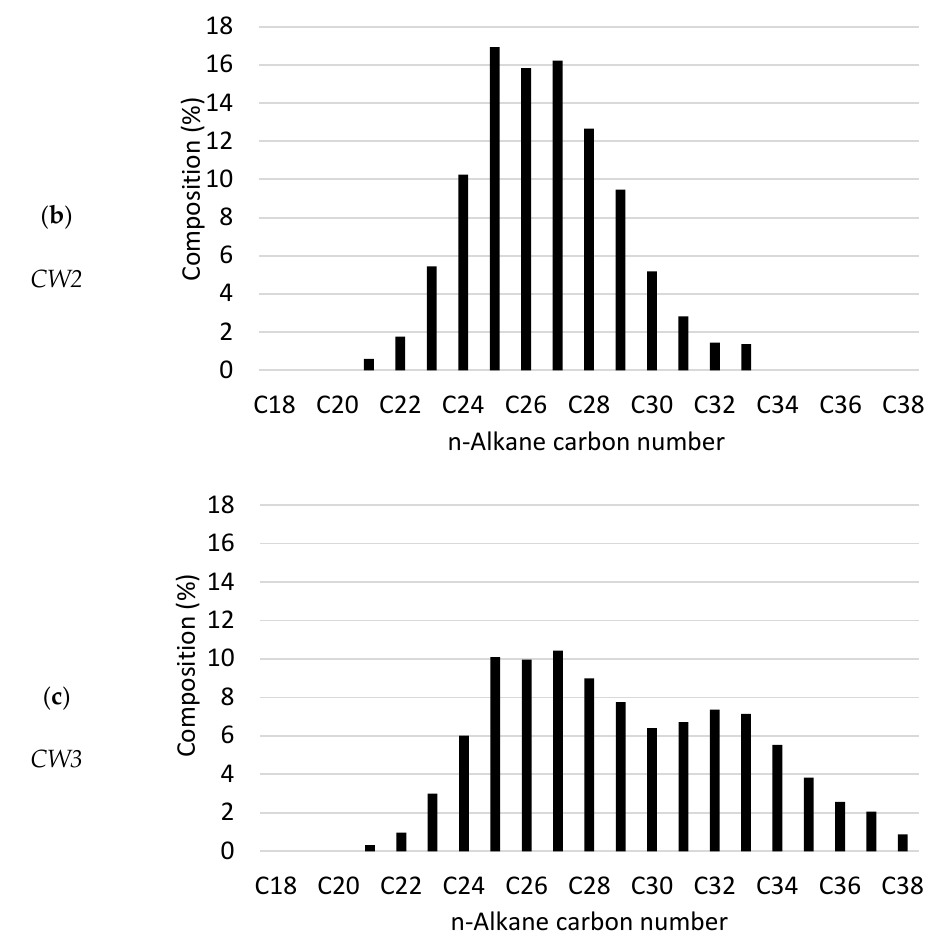
Figure 1. n-Alkane carbon number distribution of wax blends: ( a ) CW1 , ( b ) CW2 , and ( c ) CW3 obtained by gas chromatography.